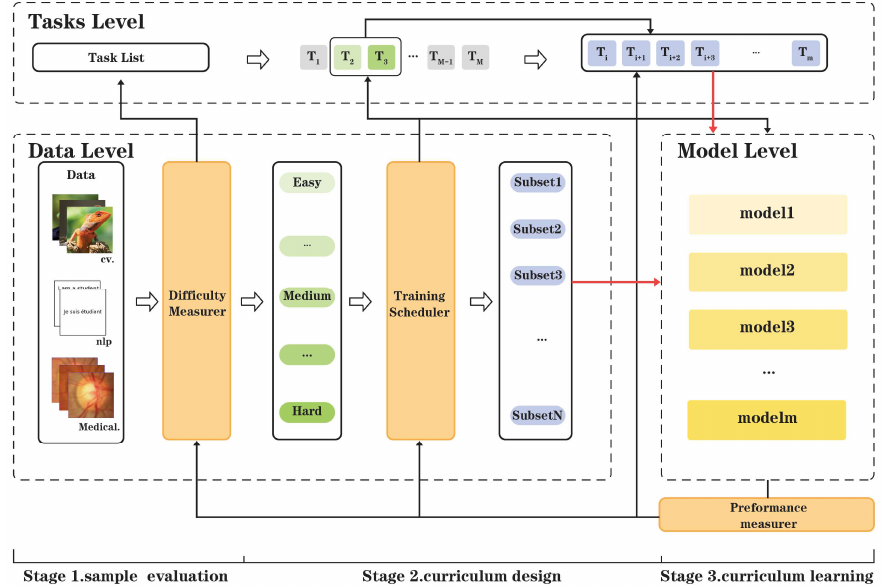
Figure 3. A framework for curriculum learning methods, including three main levels of data, tasks, and